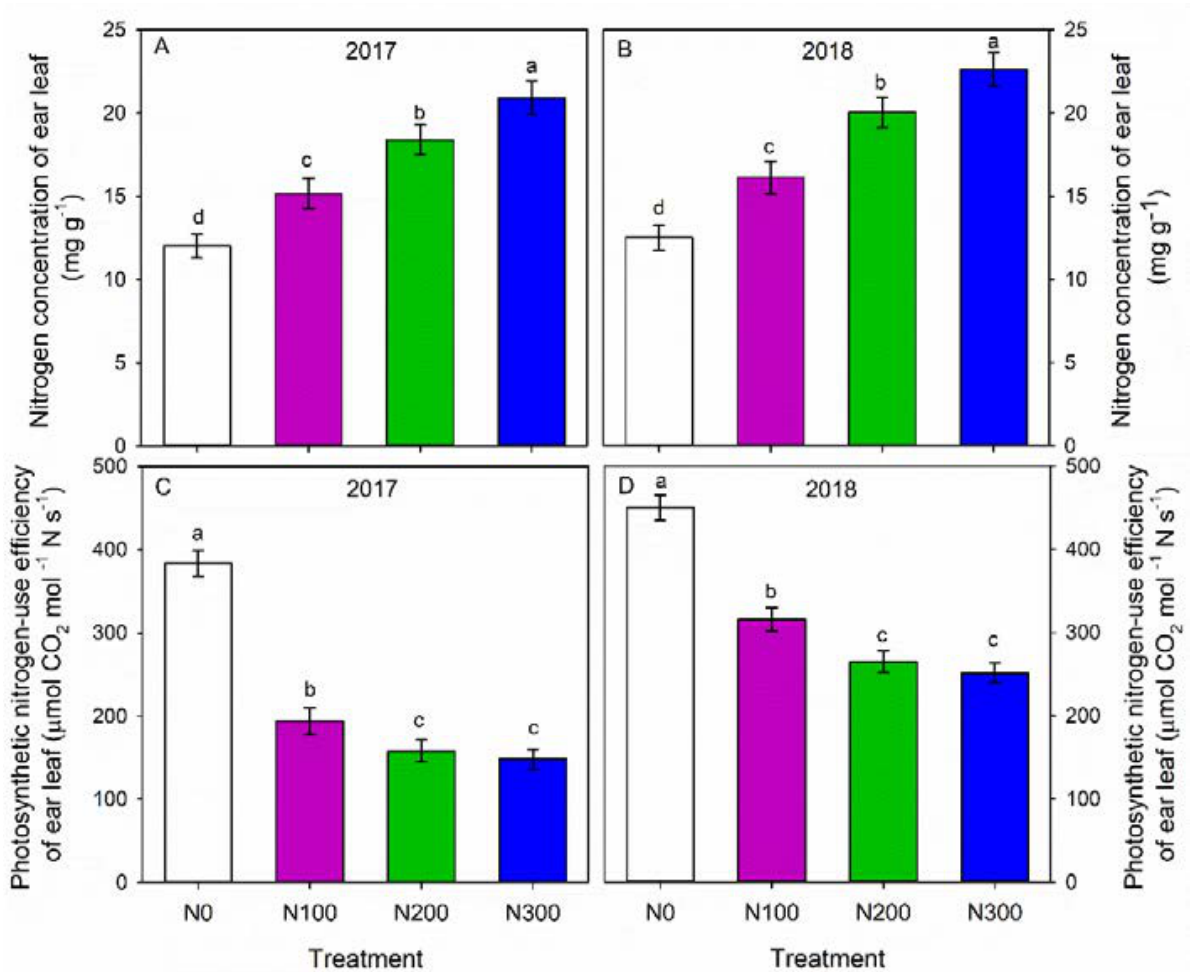
Figure 4. Nitrogen concentration ( A , B ) and photosynthetic nitrogen use efficiency of the ear leaf ( C , D ) in 2017 and 2018. Error bars indicate standard deviations of the means. Within a year for a given dependent variable, different letters indicate treatment means that are significantly different ( p ≤ 0.05). The nitrogen × year interaction was not statistically significant for nitrogen concentration and photosynthetic nitrogen use efficiency of the ear leaf.